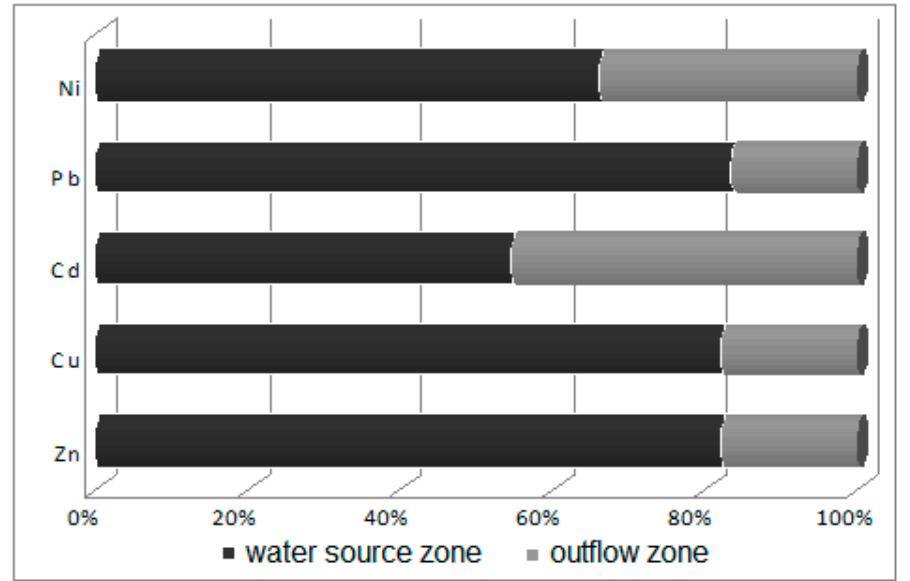
Figure 7. Ratio of water heavy metal concentrations in the water source zone to those in the outflow zone.